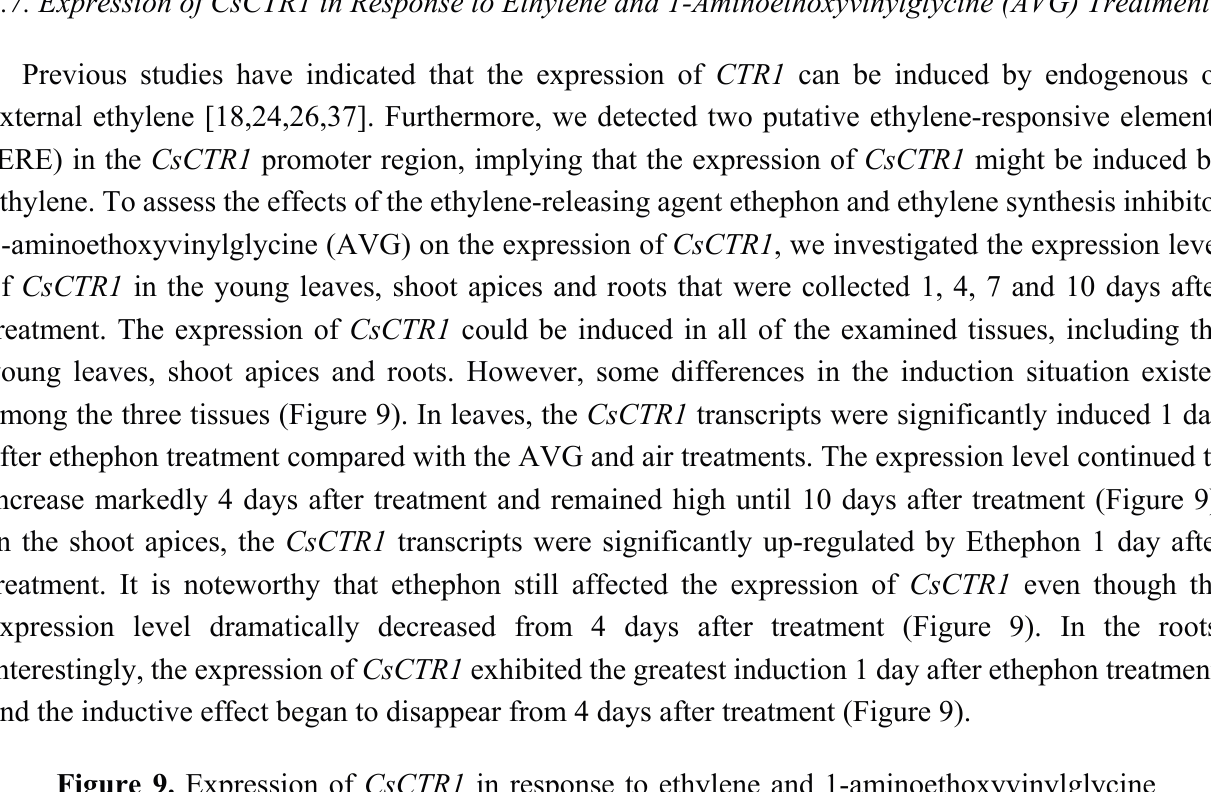
Figure 9. Expression of CsCTR1 in response to ethylene and 1-aminoethoxyvinylglycine (AVG) treatment. The expression of CsCTR1 in different organs was determined by qRT-PCR at 1, 4, 7 and 10 days after treatment with ethephon or AVG. Error bars on each column indicate standard deviation from three biological replicates. Columns with different lowercase letters are statistically different using the significant difference test of one-way ANOVA ( p <